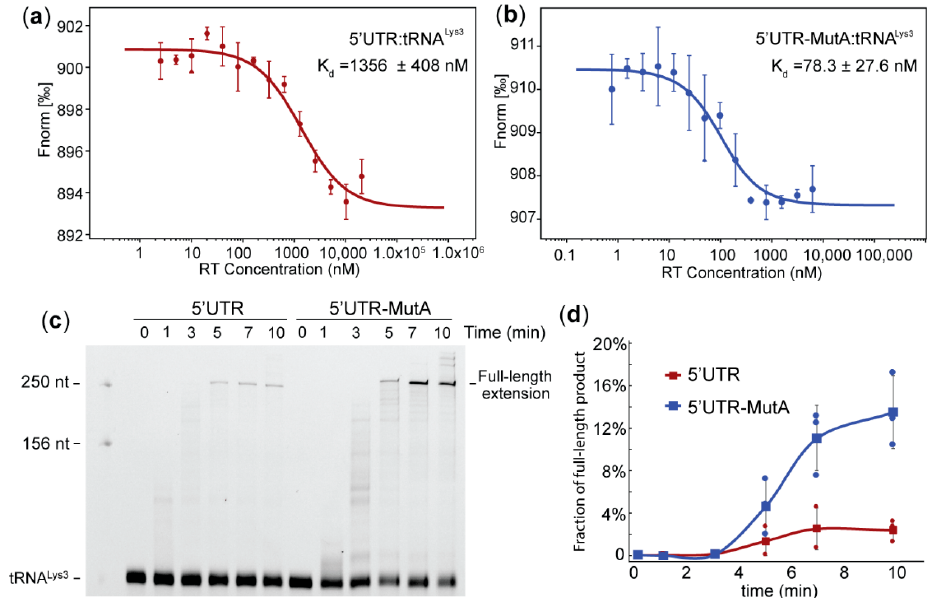
Figure 3. Mutation of the A-Rich loop led to increased affinity for reverse transcriptase (RT) binding to the vRNA: tRNA Lys3 complex and increased primer extension efficiency in vitro. ( a ) microscale thermophoresis (MST)-binding curve of RT binding to the 5 ′ UTR: tRNA Lys3 complex. ( b ) MST-binding curve of RT binding to the 5 ′ UTR-MutA: tRNA Lys3 complex. Representative curves of three independent experiments are shown in ( a , b ), average ± standard deviation. ( c ) Mutation of the A-rich loop in the template RNA led to an increased primer extension. The primer extension products of Cy3-labeled tRNA Lys3 on the 5 ′ UTR WT (left) and 5 ′ UTR-MutA (right) were visualized by polyacrylamide gel electrophoresis and imaged by fluorescent scanning. ( d ) Quantification of the full-length primer extension products averaged from three independent experiments shows enhanced primer extension efficiency upon mutation of the A-rich loop.